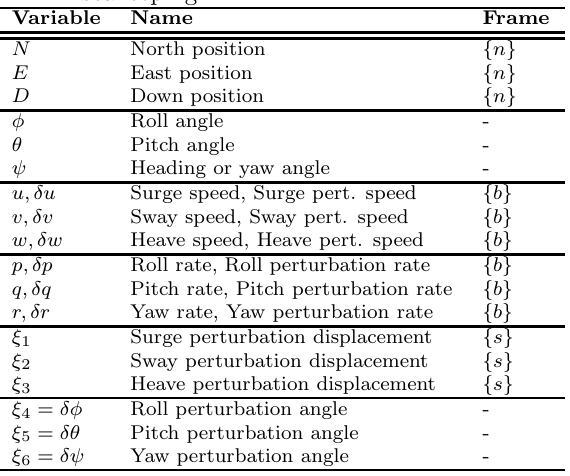
Table 1: Scalar variables used the manoeuvring and seakeeping.